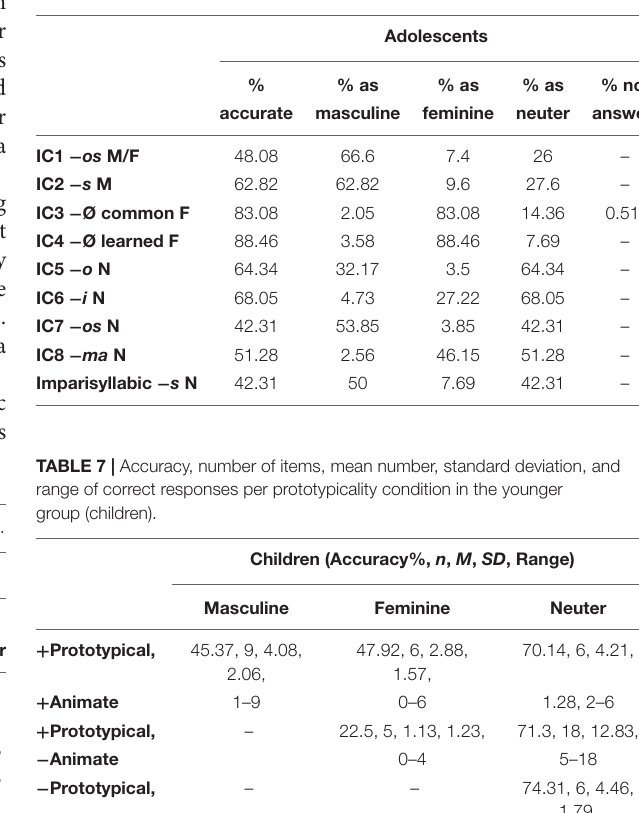
TABLE 6 | Accuracy and distribution of the adolescents’ answers for the Real Nouns.